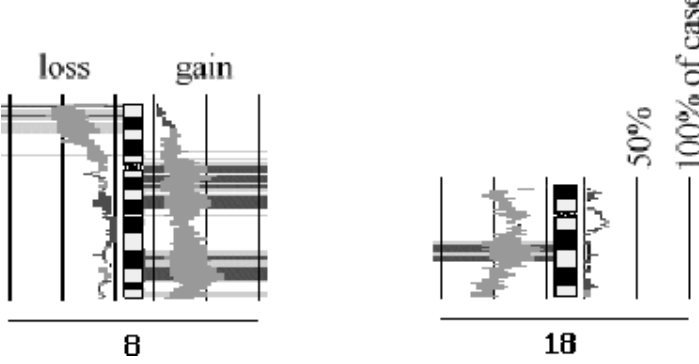
Fig. 7. Differences of chromosomal imbalances between peridiploid and peritetraploid tumors expressed as histogram. The percentage of cases with imbalances is displayed by the colored areas (dark gray for the peridiploid tumors; light gray for the peritetraploid tumors) on both sides of the ideogram chromosomes. The statistical analysis is based on an Chi-square-test integrated in CGH software. Significant differences are displayed by light gray bars for a significance level p 6 5% and by dark gray bars for a significance level p 6 1%. The modification of the statistical analysis for this study is described in the part Material and methods. The peritetraploid tumors showed more gains on 8q12–q21 and 8q23–q24.1 and more losses on 8p22–p23 and 18q12–q21 than the peridiploid tumors.